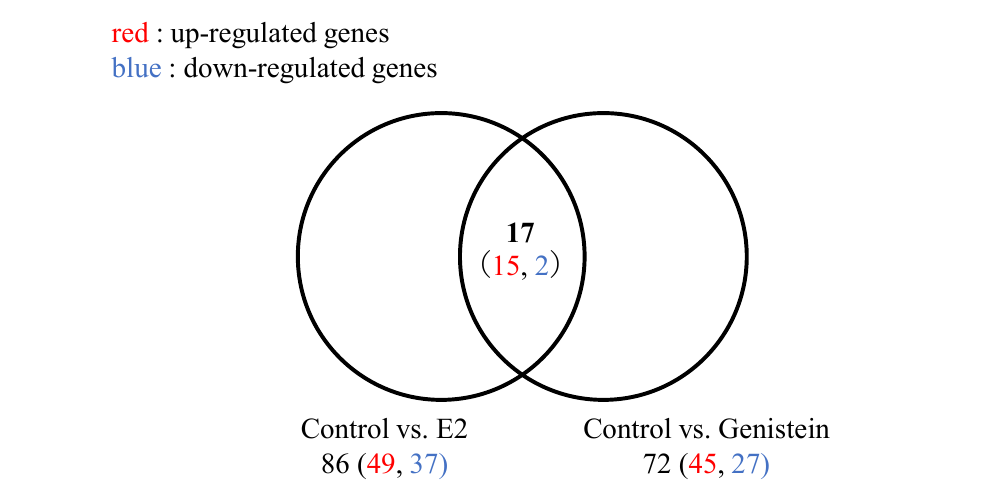
Figure 5. E2- and genistein-induced changes in gene expression. Venn diagram showing the number of differentially expressed genes with expression changes of >10-fold in E2- and genistein-treated eels compared with the genes of control eels. Table 1. Differentially expressed genes with FPKM values that changed by >10-fold in both E2- and genistein-treated eels compared with the genes of control eels.